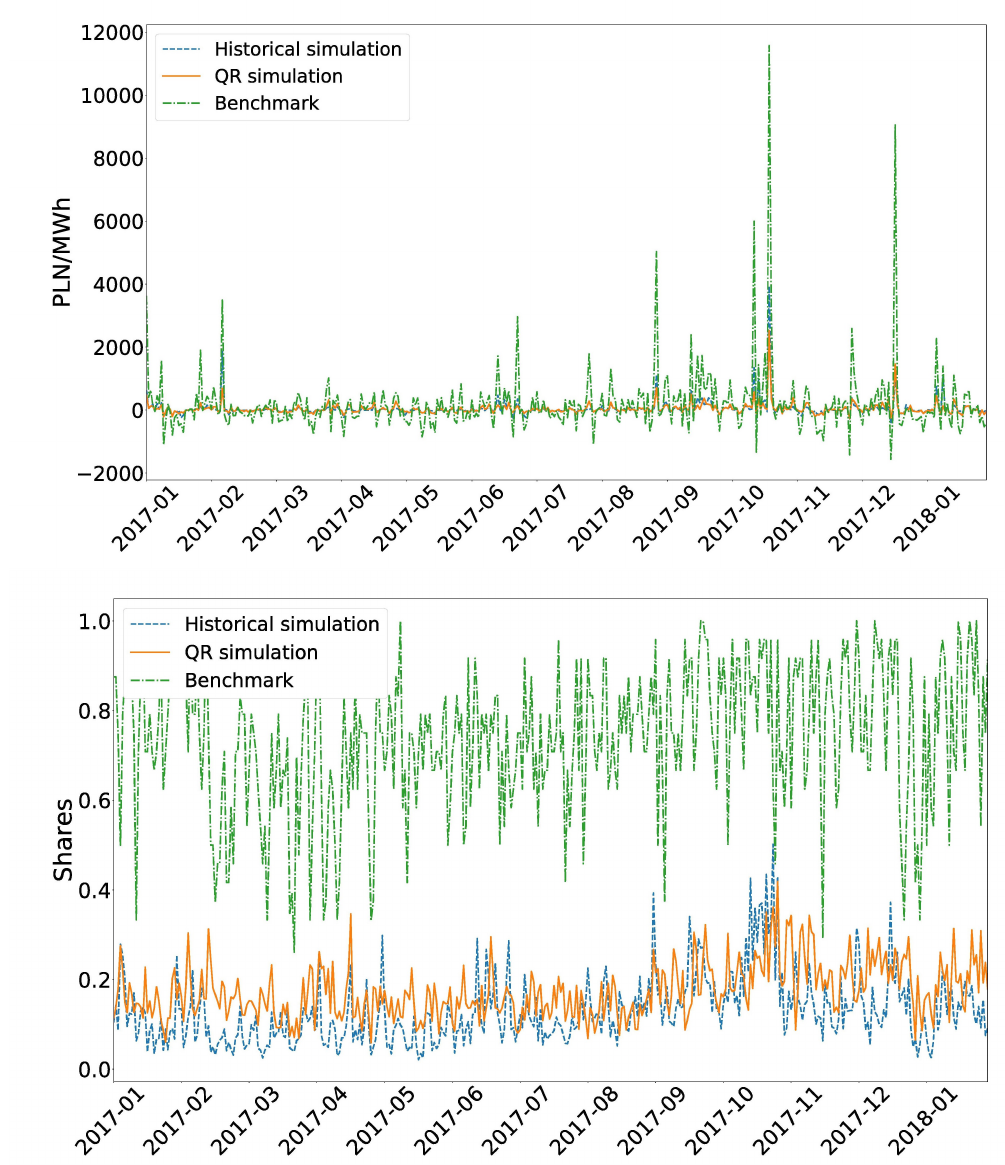
Figure 3. Daily profits from the benchmark strategy and the strategy based on maximization of the 5% quantile of the future portfolios value ( top panel ). Daily shares of sale on the balancing market associated with the benchmark strategy and the proposed 5% quantiles maximization strategy ( bottom panel ). The results of the historical method are plotted for the model structure yielding the minimal risk, i.e., with X 1 , X 2 , X 3 , and L = [ 2,7 ]